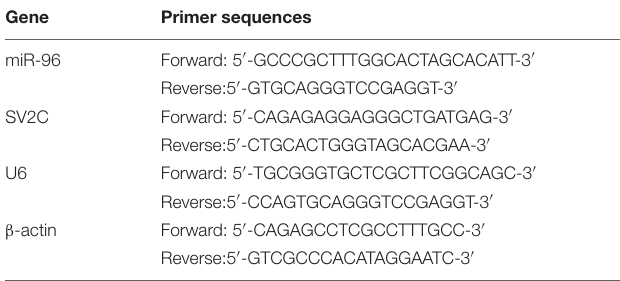
TABLE 1 | RT-qPCR primer sequences. Gene Primer